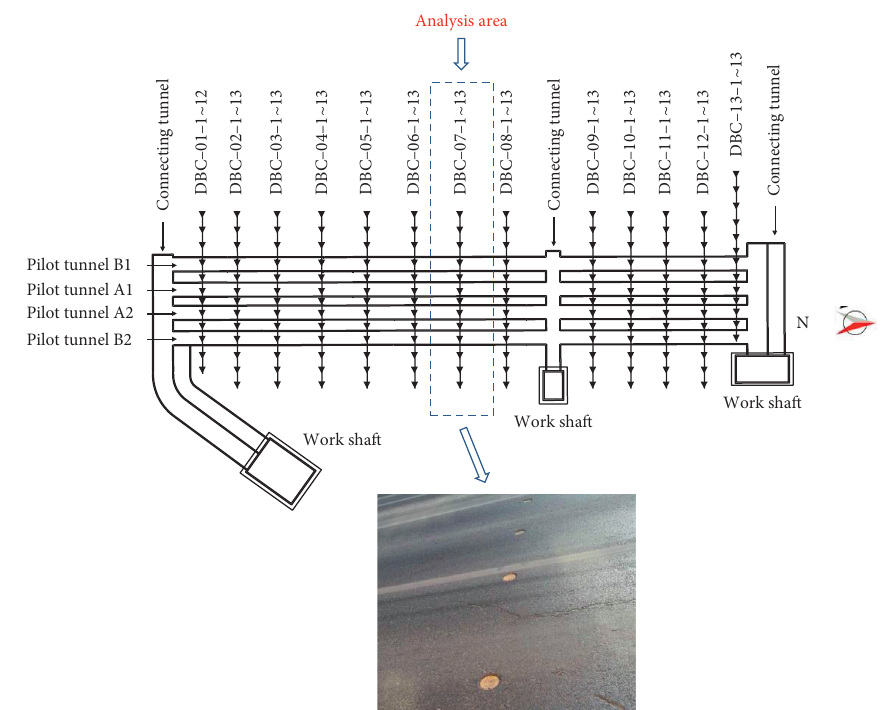
Figure 3: The plane layout of ground surface settlement monitoring